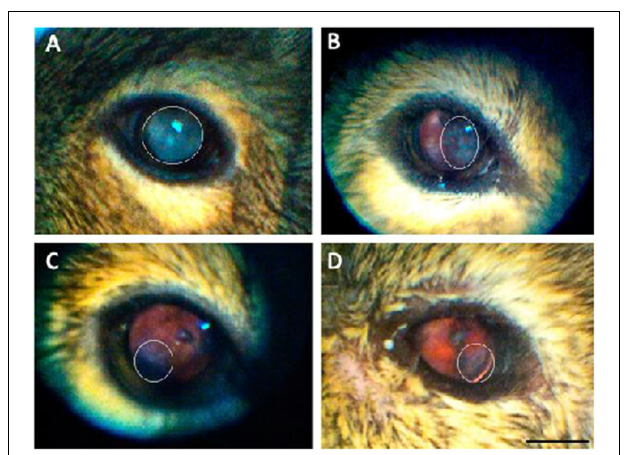
FIGURE 1 | Representative images of the lens opacities seen in degus. (A) Servere nuclear cataract in an adult desu. (B) Moderate cortical-like cataract in an adult degu. (C) Minimal posterior sub capsular-like cataract in an adult degu. (D) Mild posterior sub capsular-like cataract in an aged adult degu. White elliptical marquee shows opacity area. Scale bar in (D) = 5 mm.